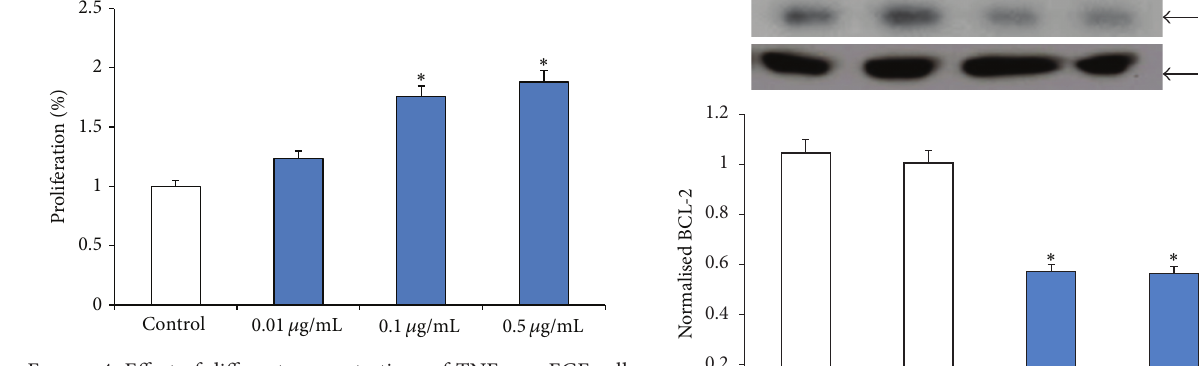
Figure 4: Effect of different concentrations of TNF 𝛼 on EGE cell proliferation. Cell proliferation in EGE cell treated with different concentrations of TNF 𝛼 was assessed using CyQuant assay as described in Methods. Results are expressed as means ± SE from 3 separate experiments. ∗ Significantly different from the control ( 𝑃 < 0.05 ).